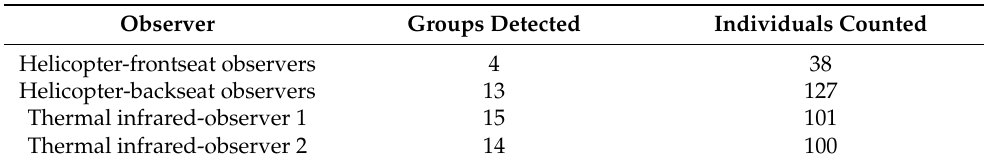
Table 1. Tally of raw counts of bison groups detected and individuals counted by each observer between independent helicopter and thermal infrared surveys, Powell Plateau, Grand Canyon National Park, USA, 11 February 2020. Groups Detected Individuals Counted